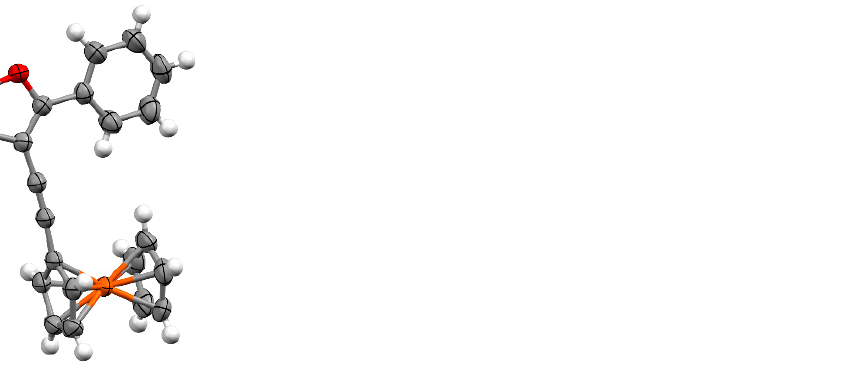
Figure 2. Cyclic voltammograms of ferrocene-benzofuran hybrids and ferrocene (Fc) (working electrode: glassy carbon, reference electrode: Ag/AgCl (H 2 O), auxiliary electrode: Pt wire, concen- tration: 2.5 × 10 − 3 M in CH 2 Cl 2 , supporting electrolyte: 0.1 M n -Bu 4 NPF 6 , scan rate: 50 mV/s). Table 2. Diffusion coefficients ( D ), half wave potentials ( E 1/2 ) and redox potentials relative to fer- rocene ( E rel ) of ferrocene–benzofuran hybrids a . Compound